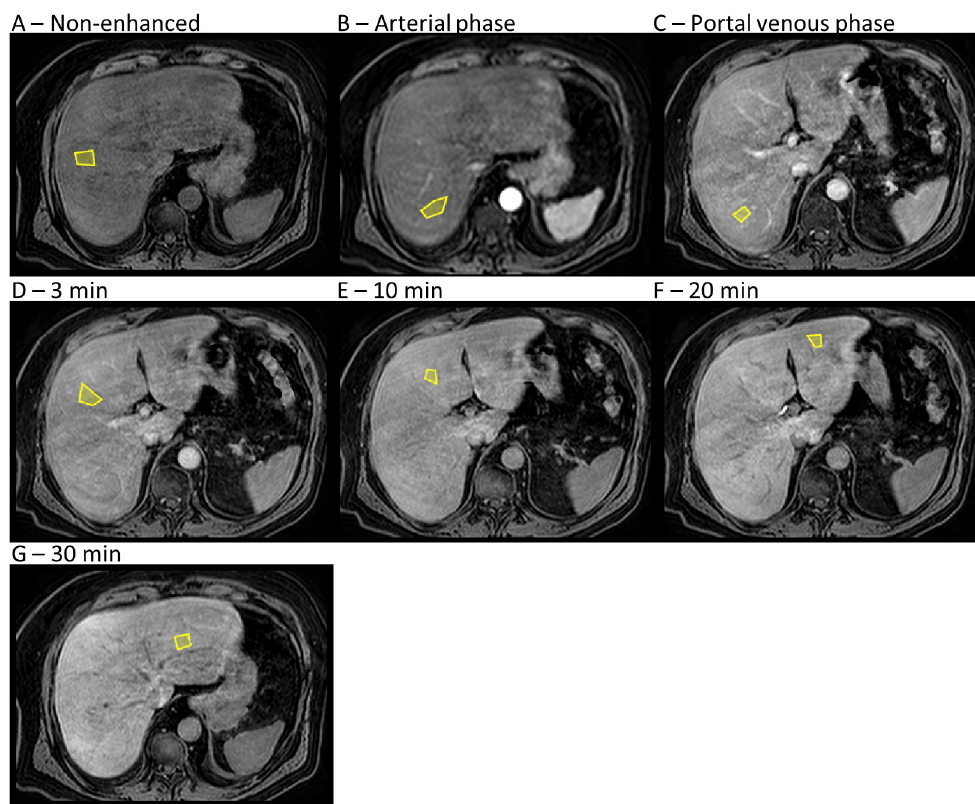
Fig 5. Gadoxetate MRI time series of the liver. ( A - G ) Representative placement of seven regions of interest (yellow polygons) within the liver, of which four ( A - D ) were placed in the right liver lobe and three ( E - G )were placed in the left liver lobe. This set shows an entire time series in a single patient, from before gadoxetate injection ( A ) to 30 min after gadoxetate injection ( G ). The arterial phase ( B ) typically occurs 30 s after gadoxetate injection, and the portal-venous phase ( C ) typically occurs 1 min after gadoxetate